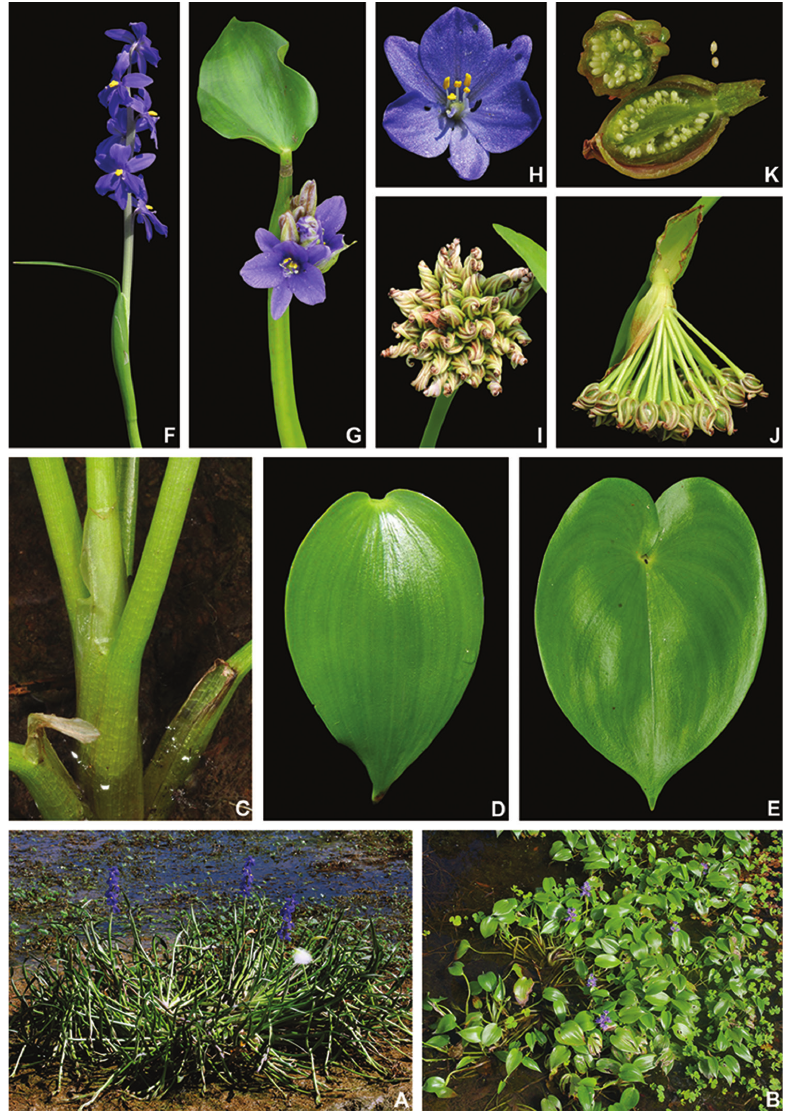
Figure 6. Pontederia subg. Monochoria (C.Presl) M.Pell. & C.N.Horn. A–B habit: A paludal habit of P. australasica (Ridl.) M.Pell. & C.N.Horn B paludal habit of P. cyanea (F.Muell.) M.Pell. & C.N.Horn C ligule of P. vaginalis Burm.f., showing the truncate apex D–E petiolate leaf-blades: D blade of P. cyanea , showing the lack of a posterior division E blade of P. vaginalis , showing the presence of a posterior division F–G inflorescences: F inflorescence of P. australasica , showing the developed main axis G inflorescence of P. plantaginea Roxb., showing the contracted main axis H front view of a flower of P. korsakowii (Regel & Maack) M.Pell. & C.N.Horn I–J inflorescences at post-anthesis: I erect inflorescence of P. hastata L. bear- ing flowers at post-anthesis J infructescence of P. hastata , showing the deflexed posture and the elongated pedicels K sections of immature capsules of P. vaginalis , showing developing seeds. A, F by M. Barritt B by R. Cumming C, E, K by P.B. Pelser & J.F. Barcelona D by A. & S. Pearson G by D. Valke H by Ashitaka-f Studio and I & J by Cerlin